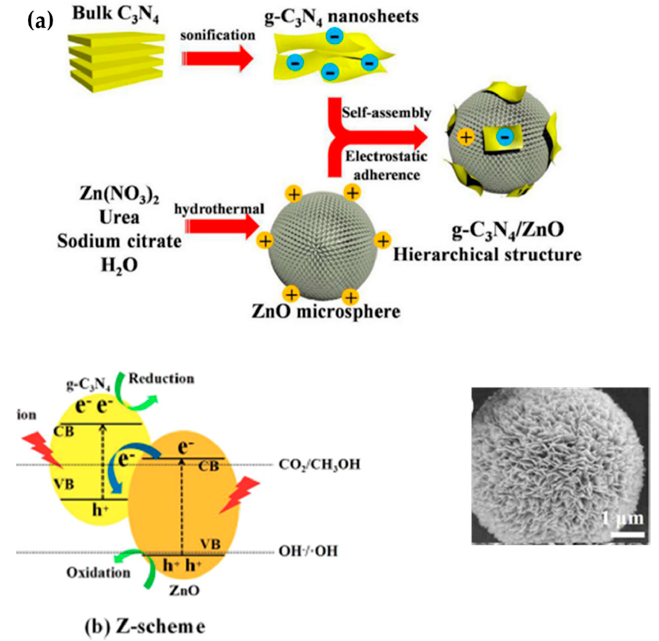
Figure 16. Synthesis scheme ( a ) and Z-scheme heterojunction ( b ) for g-C 3 N 4 /ZnO hierarchical microspheres [171].